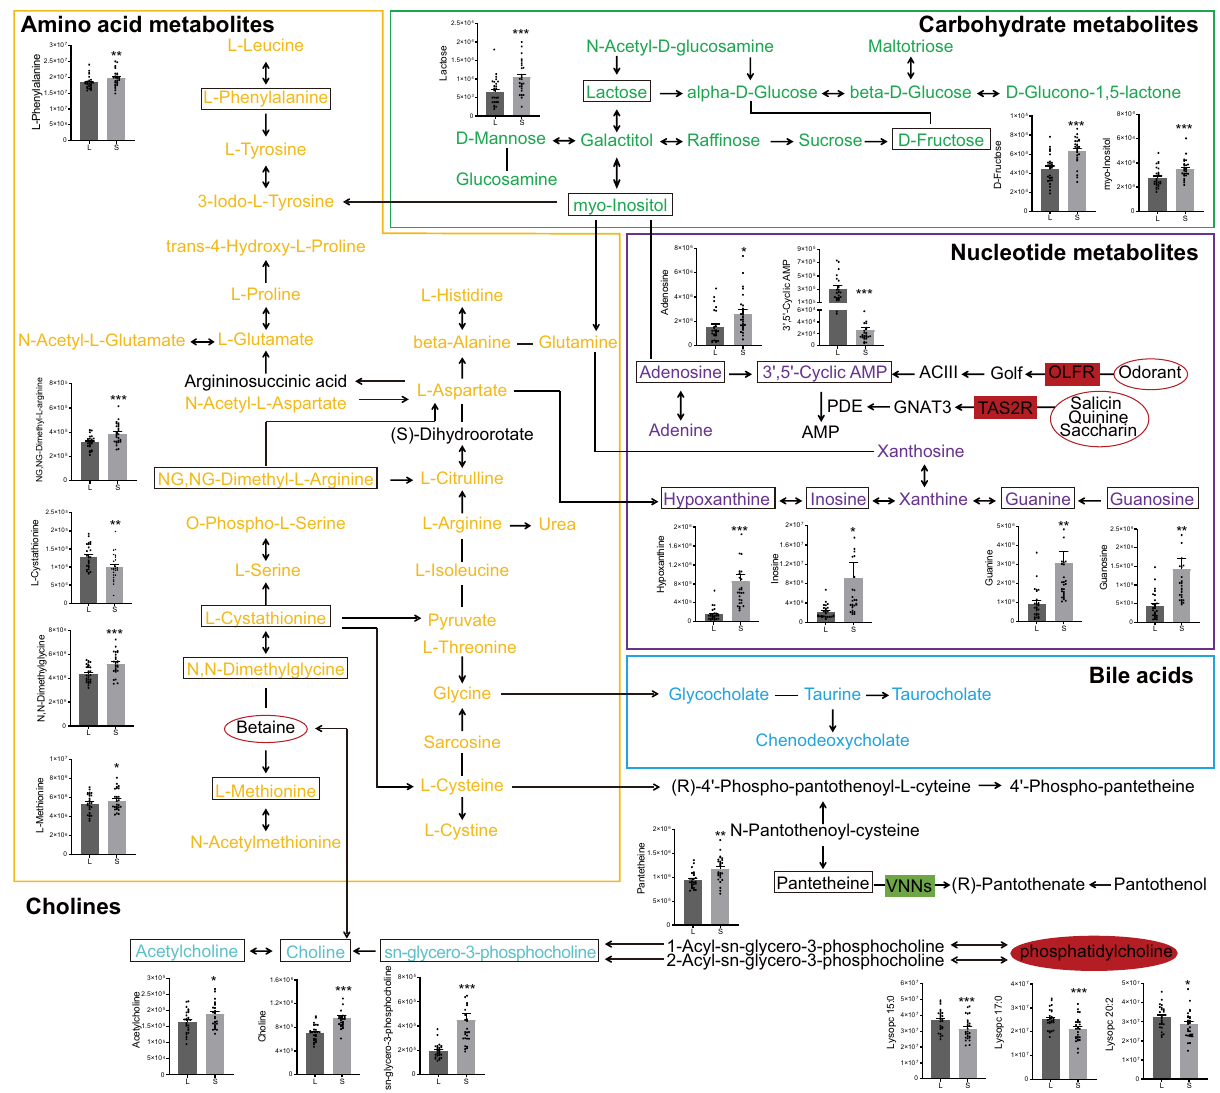
Fig. 4 A schematic diagram of the complex inter-material pathway network. It was formed by the direct interaction of differential metabolites and differential RNAs of the human follicular fl uid from follicles of different sizes based on KEGG pathway map. The pro fi led metabolites are shown in the pathway network, and the signi fi cantly differential metabolites are presented as mean ± standard error of the mean (SEM). The gene colored red indicates increase in small follicles when compared with large follicles; the gene colored green indicates decrease in small follicles when compared with large